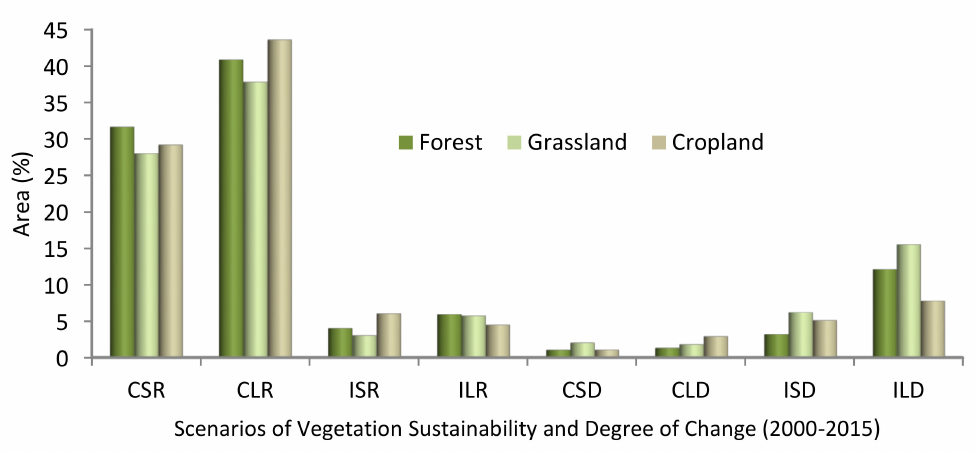
Figure 15. Sustainability and degree of NPP change under di ff erent scenarios for the restoration